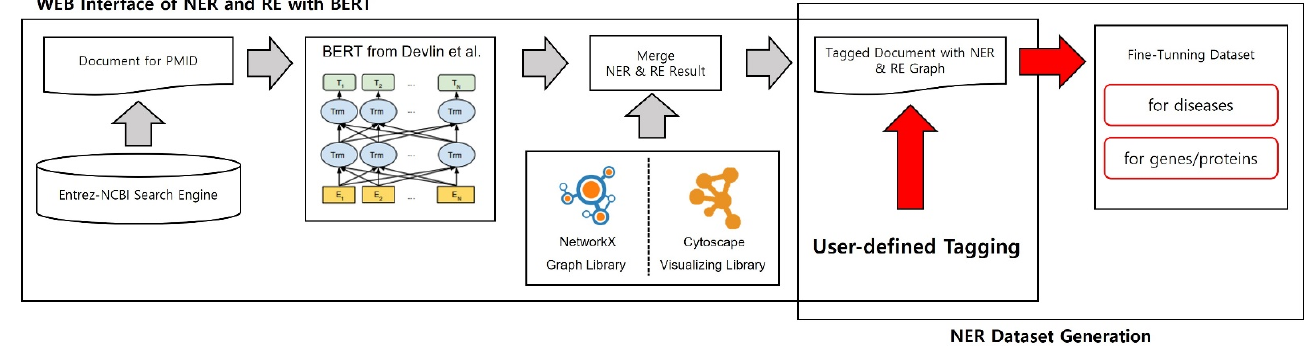
Figure 4. Overview of the proposed web interface of NER and RE with BERT.